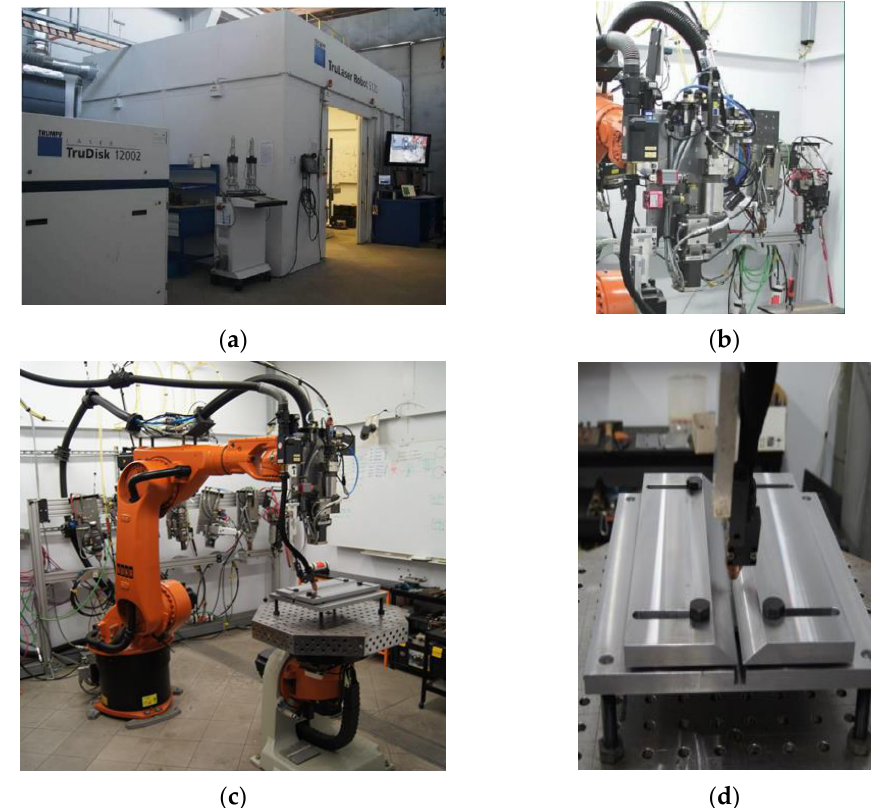
Figure 2. Robotic laser welding station (TruLaser Robot 5120) with a TruDisk 12,002 disk laser and a D70 hybrid welding head (Trumpf): ( a ) view of the booth and laser source, ( b ) hybrid head, ( c ) view of the robot with welding table, ( d ) how the welding sample is fixed.